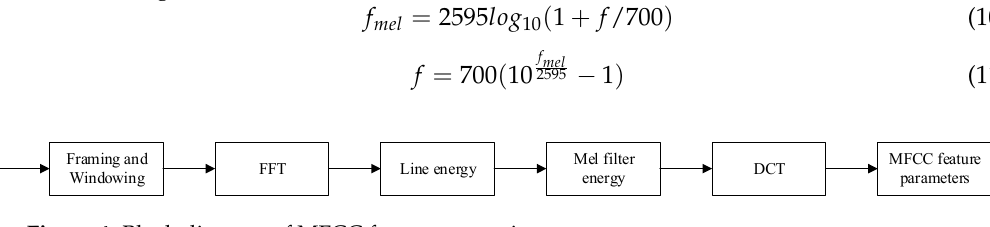
Figure 4. Block diagram of MFCC feature extraction.